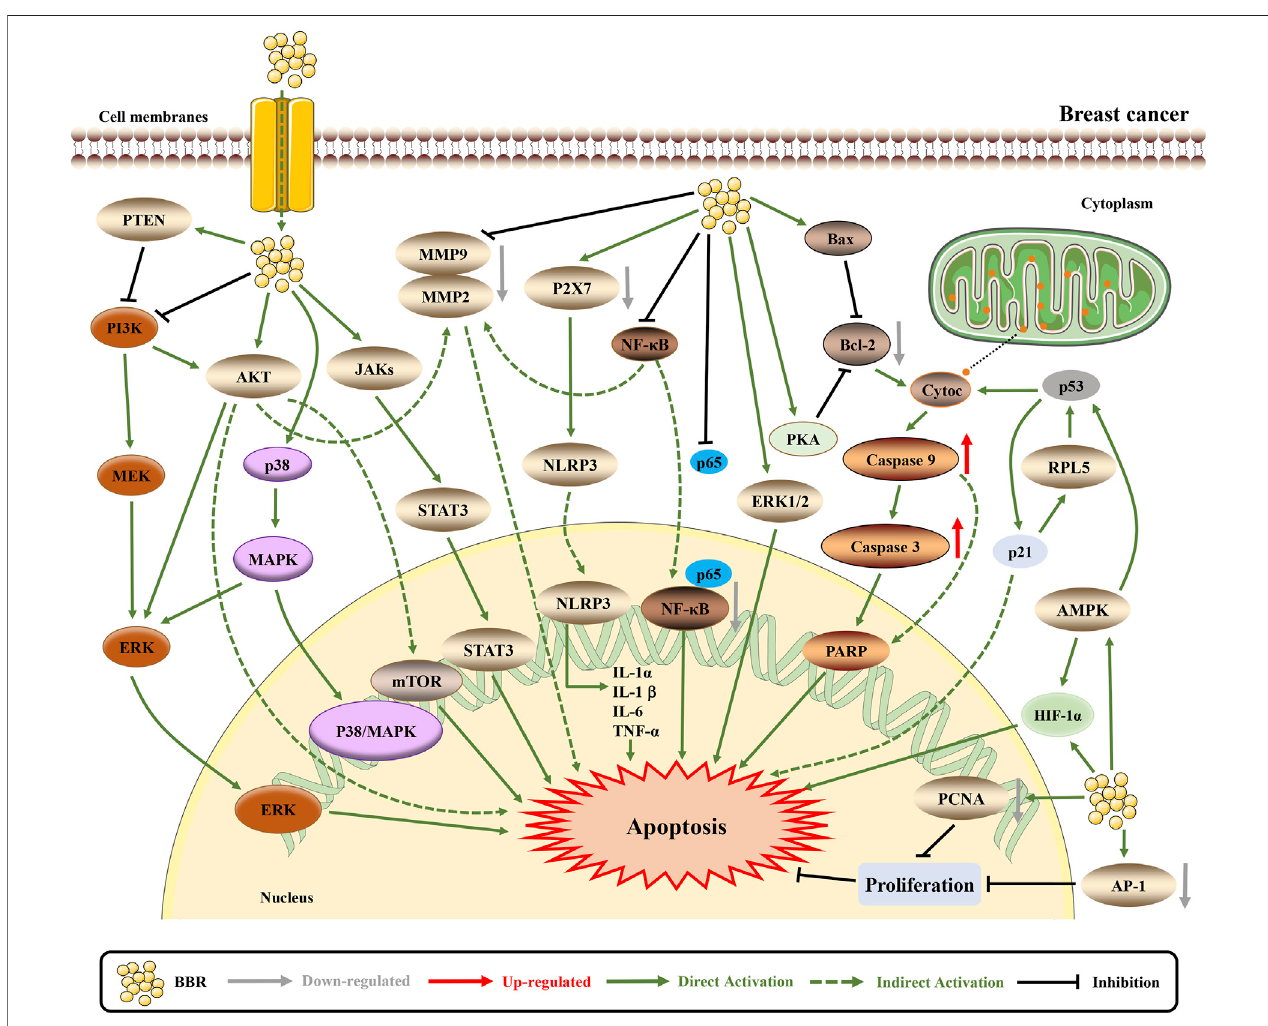
FIGURE 4 | The pro-apoptotic mechanisms of BBR in breast cancer. BBR exerts anti-cancer effects by in fl uencing breast cancer related pathways. BBR induces apoptosis through downregulatingMTDH (Sun et al.,2019).BBR actives the mitochondrial apoptotic pathway and upregulates AMPK topromote apoptosis (Pan et al., 2017; Zhao et al., 2017; Ma et al., 2020). Furthermore, BBR downregulates AKT/ERK pathway to induce cell cycle arrest and apoptosis (Lin et al., 2019). BBR inhibits NLRP3 and NF- κ B in fl ammasome pathway to suppress in fl ammation and EMT, thus inducing apoptosis (Karnam et al., 2017; Yao et al., 2019; Zhao and Zhang, 2020). The mechanism of BBR inhibiting cell proliferation, invasion and growth may be induced by EGFR/ERK and EGFR/AKT signaling pathways (Kim et al., 2018c; Jabbarzadeh Kaboli et al., 2019). BBR affects certain protein expression and structure via VASP, and downregulates AP-1 and PCNA to inhibit cell proliferation and migration, which also decreases resistance to apoptosis (Su et al., 2016; Karnam et al., 2017; Jeong et al.,